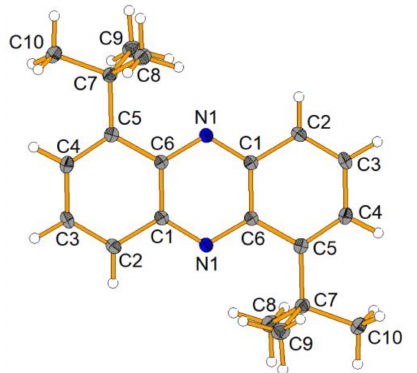
Figure A1. Molecular structure of phenazine 16 , showing a 50% probability of